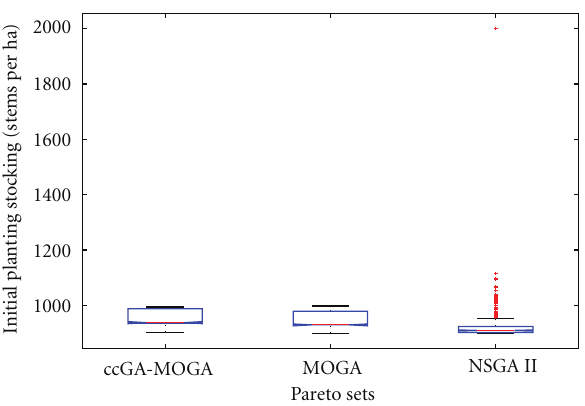
Figure 6: Box plots of the initial planting stockings from the ccGA- MOGA, MOGA, and NSGA II Pareto sets. The edges of each box represent the 25th and 75th percentiles; the ends of the whiskers are the minimum and maximum; outliers are plotted individually with the “+” sign.